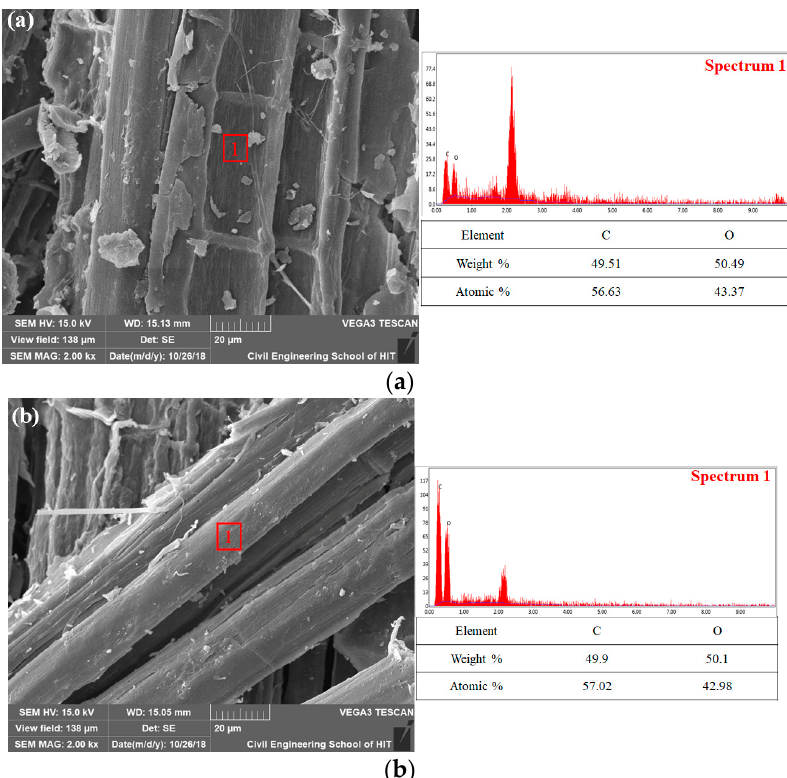
Figure 1. SEM / energy dispersive spectroscopy (EDS) image of ( a ) original flax fiber and ( b ) alkali modified flax fiber at 2000 × .